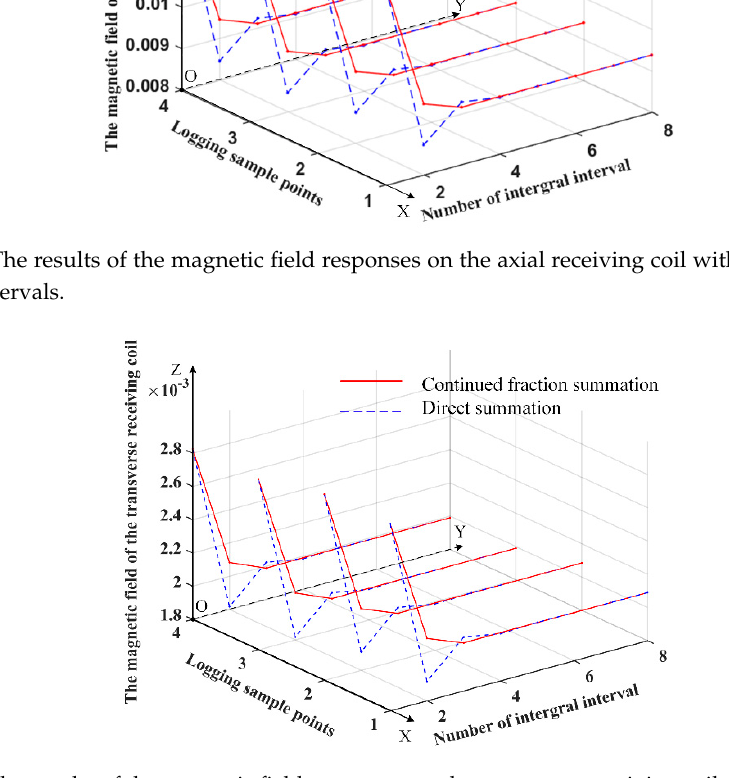
Figure 3. The results of the magnetic field responses on the transverse receiving coil with the number of integral of integral intervals.